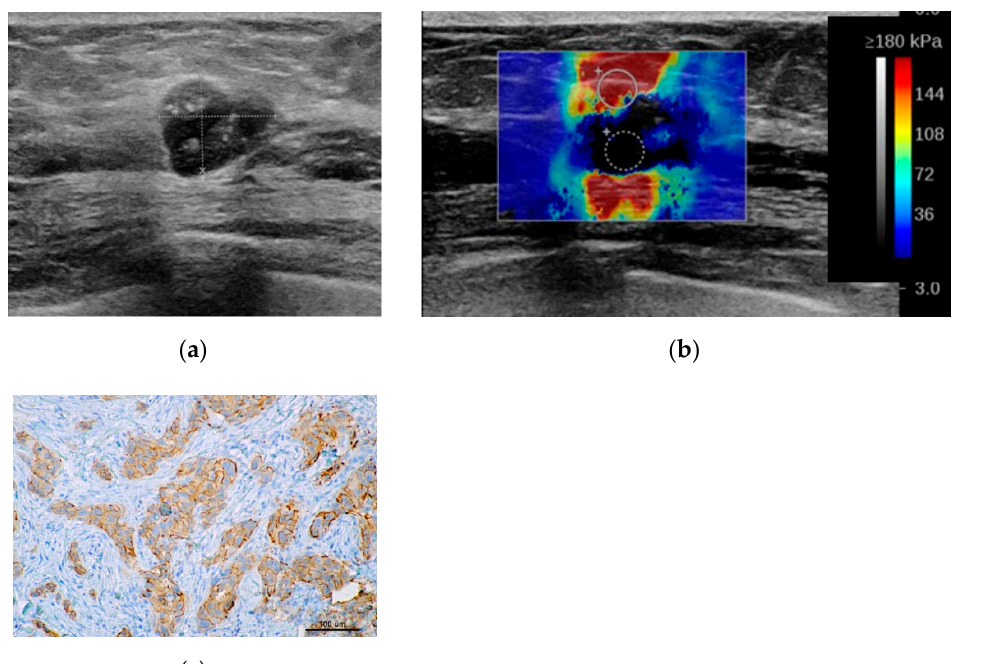
LB HER2+ = luminal B with HER2 overexpression; HER2+ = human epidermal growth factor re- ceptor 2 positive; OR = odds ratio, CI = confidence interval.